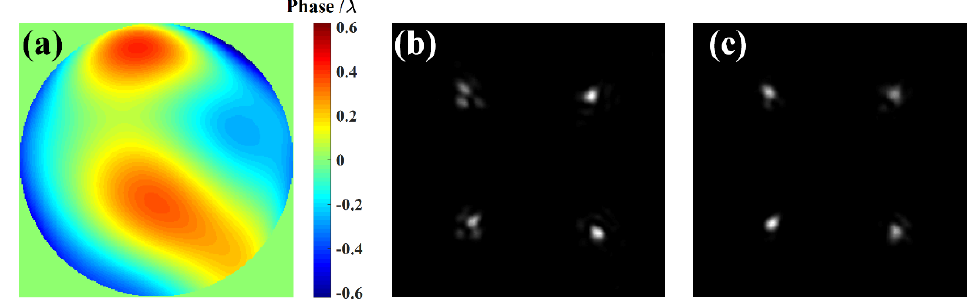
Figure 13. Incident wavefront and camera-acquired spot intensity distribution. ( a ) Incident wavefront. ( b ) The camera-acquired spot intensity distribution of the FBPM-SHWFS. ( c ) The camera-acquired spot intensity distribution of the SHWFS.